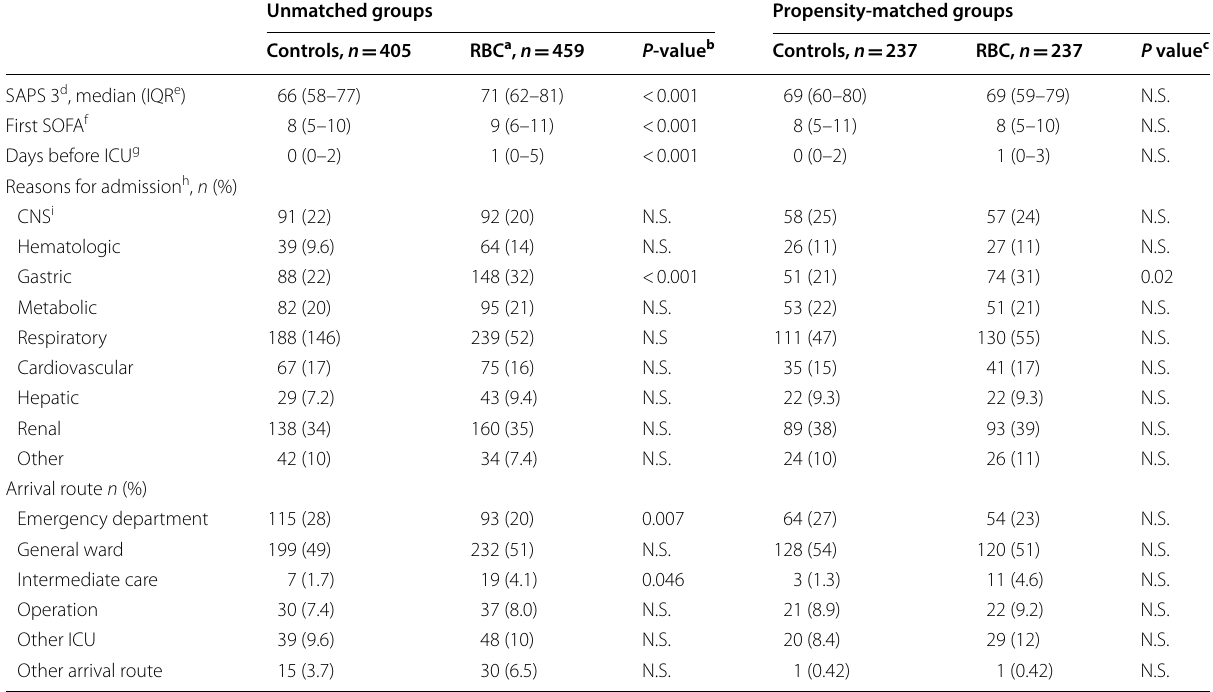
Table 2 Unmatched baseline characteristics